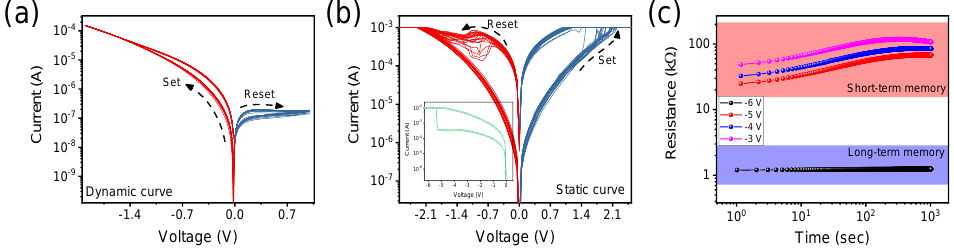
Figure 2. ( a ) The dynamic curves of ITO/SnO X /TaN device, which switched before the forming process. ( b ) The static curves of ITO/SnO X /TaN device, which switched after the forming process. The inset image shows the forming process. ( c ) The retention in the room temperature for 10 3 s. The application regions were divided into short-term and